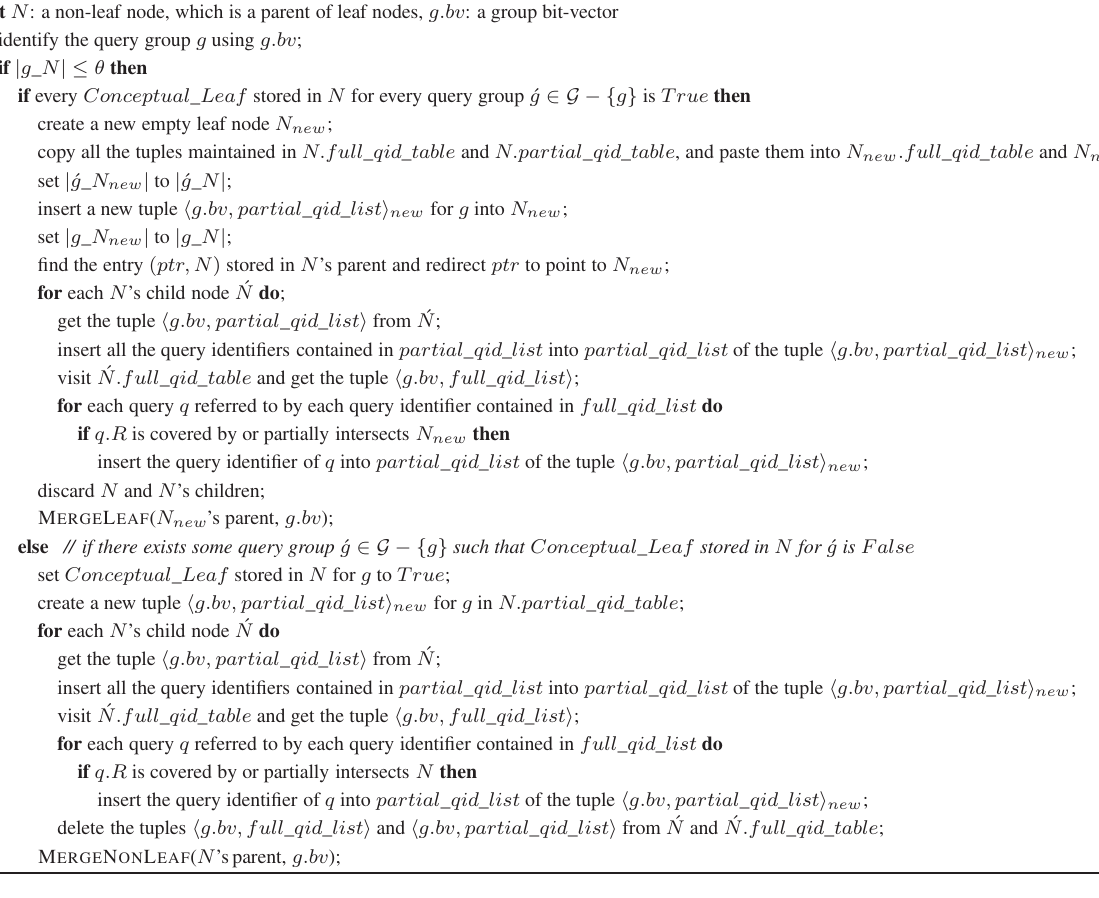
Algorithm 8 M ERGE L EAF ( N, g.bv